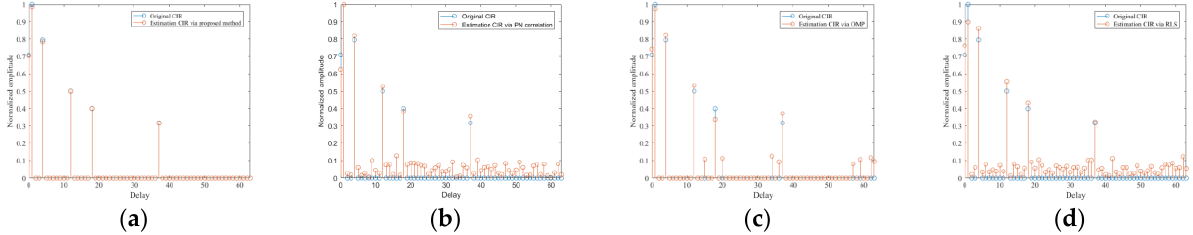
Figure 7. CIR estimation results in Brazil A channel of different method: ( a ) proposed method; ( b ) PN correlation method; ( c ) OMP method; ( d ) RLS method.